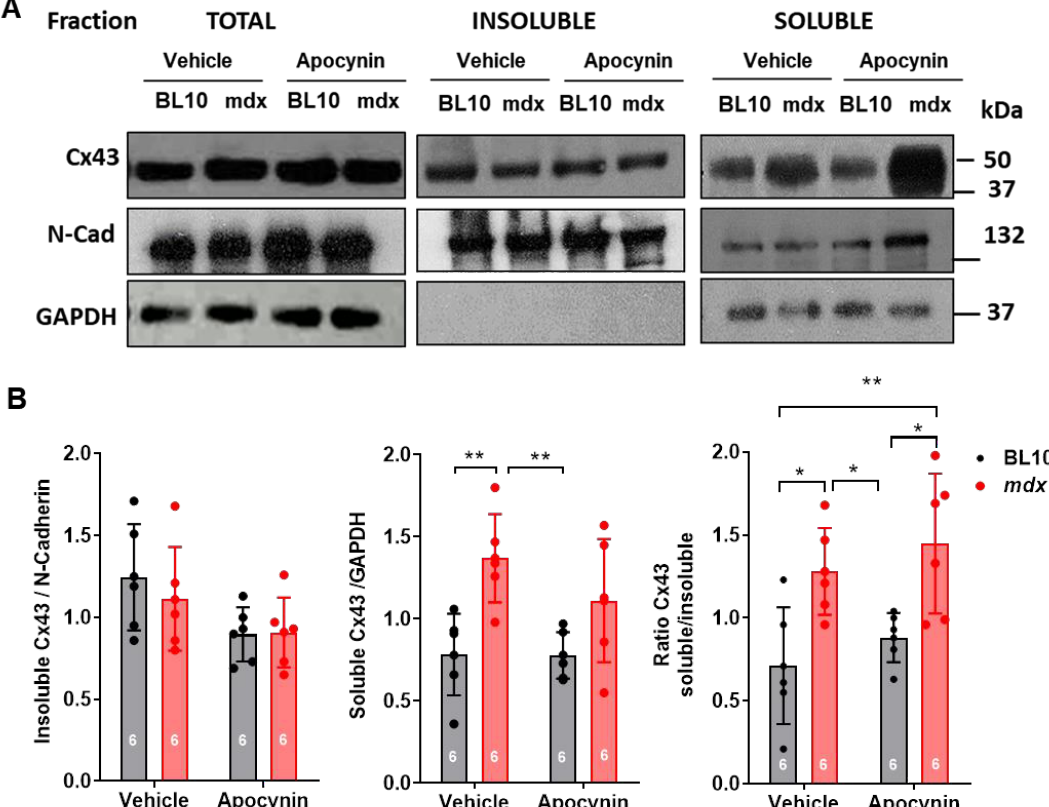
Figure 6. Increased levels of nonjuctional connexin 43 (Cx43) in dystrophic hearts. Controls (BL10) and mdx mice were treated with the vehicle or apocynin for one month. At the end of this period, hearts were harvested for tissue fractionation to separate into soluble (non-junctional) and insoluble (junctional) fractions. Resulting samples of each fraction were probed for connexin 43 (Cx43), N-cadherin (N-Cad) and GAPDH. ( A ) Representative Western blots for Cx43, N-Cad and GAPDH in each fraction. M.W., molecular weight of markers, kDa, kilodaltons. ( B ) Left, graph depicting the ratio of Cx43 insoluble to N-Cad. Middle, ratio of Cx43 to GAPDH in the soluble fraction. Right, ratio of Cx43 soluble to insoluble content. * p < 0.05, ** p < 0.005 for comparison indicated by brackets, ANOVA with Newman–Keuls as post-hoc test. n = 6 hearts in each group.